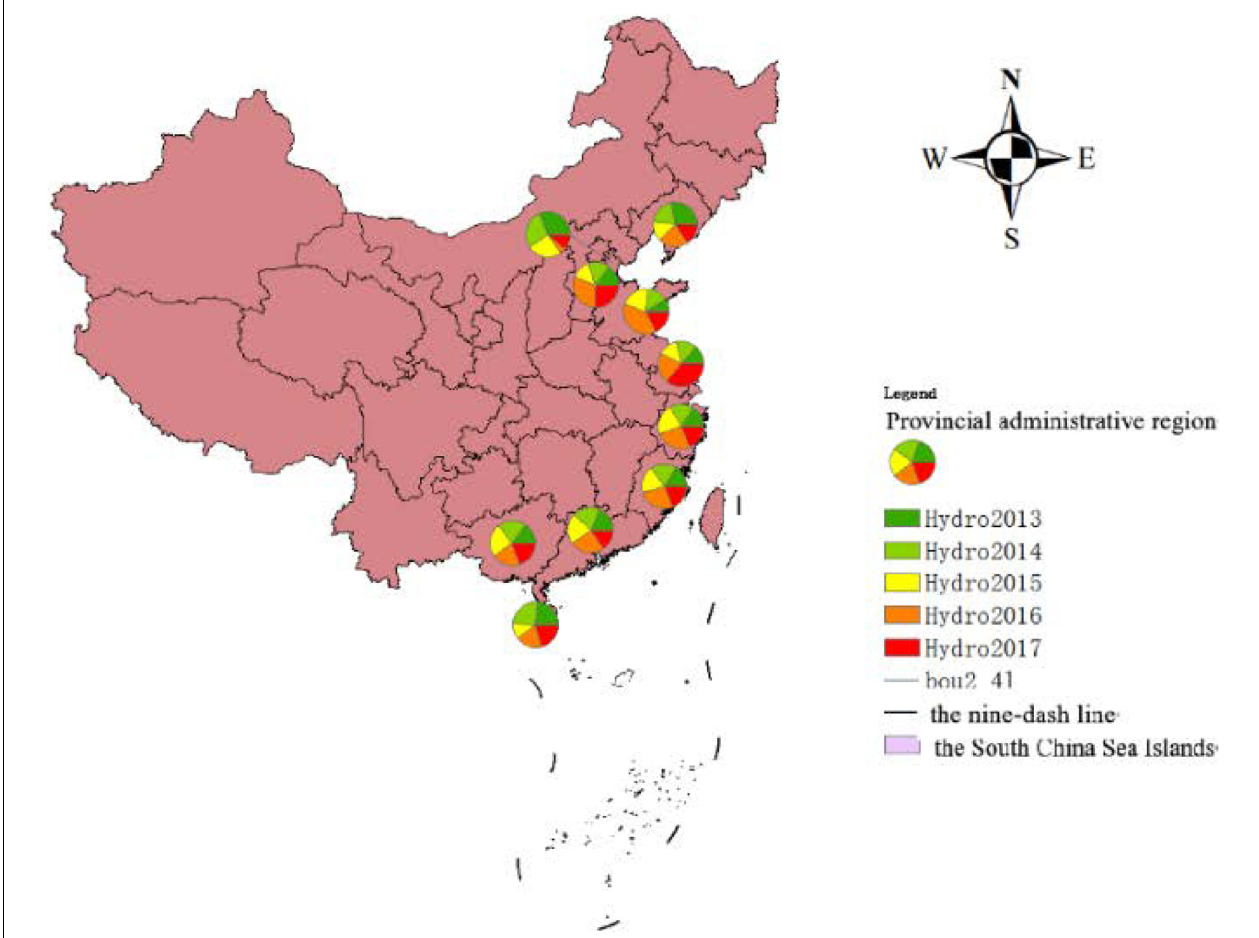
FIGURE 2 | Hydroelectric power generation of China’s coastal provinces from 2013 to 2017. The dark green is the 2013 data, the light green is the 2014 data, the yellow is the 2015 data, the orange is the 2016 data, and the red is the 2017